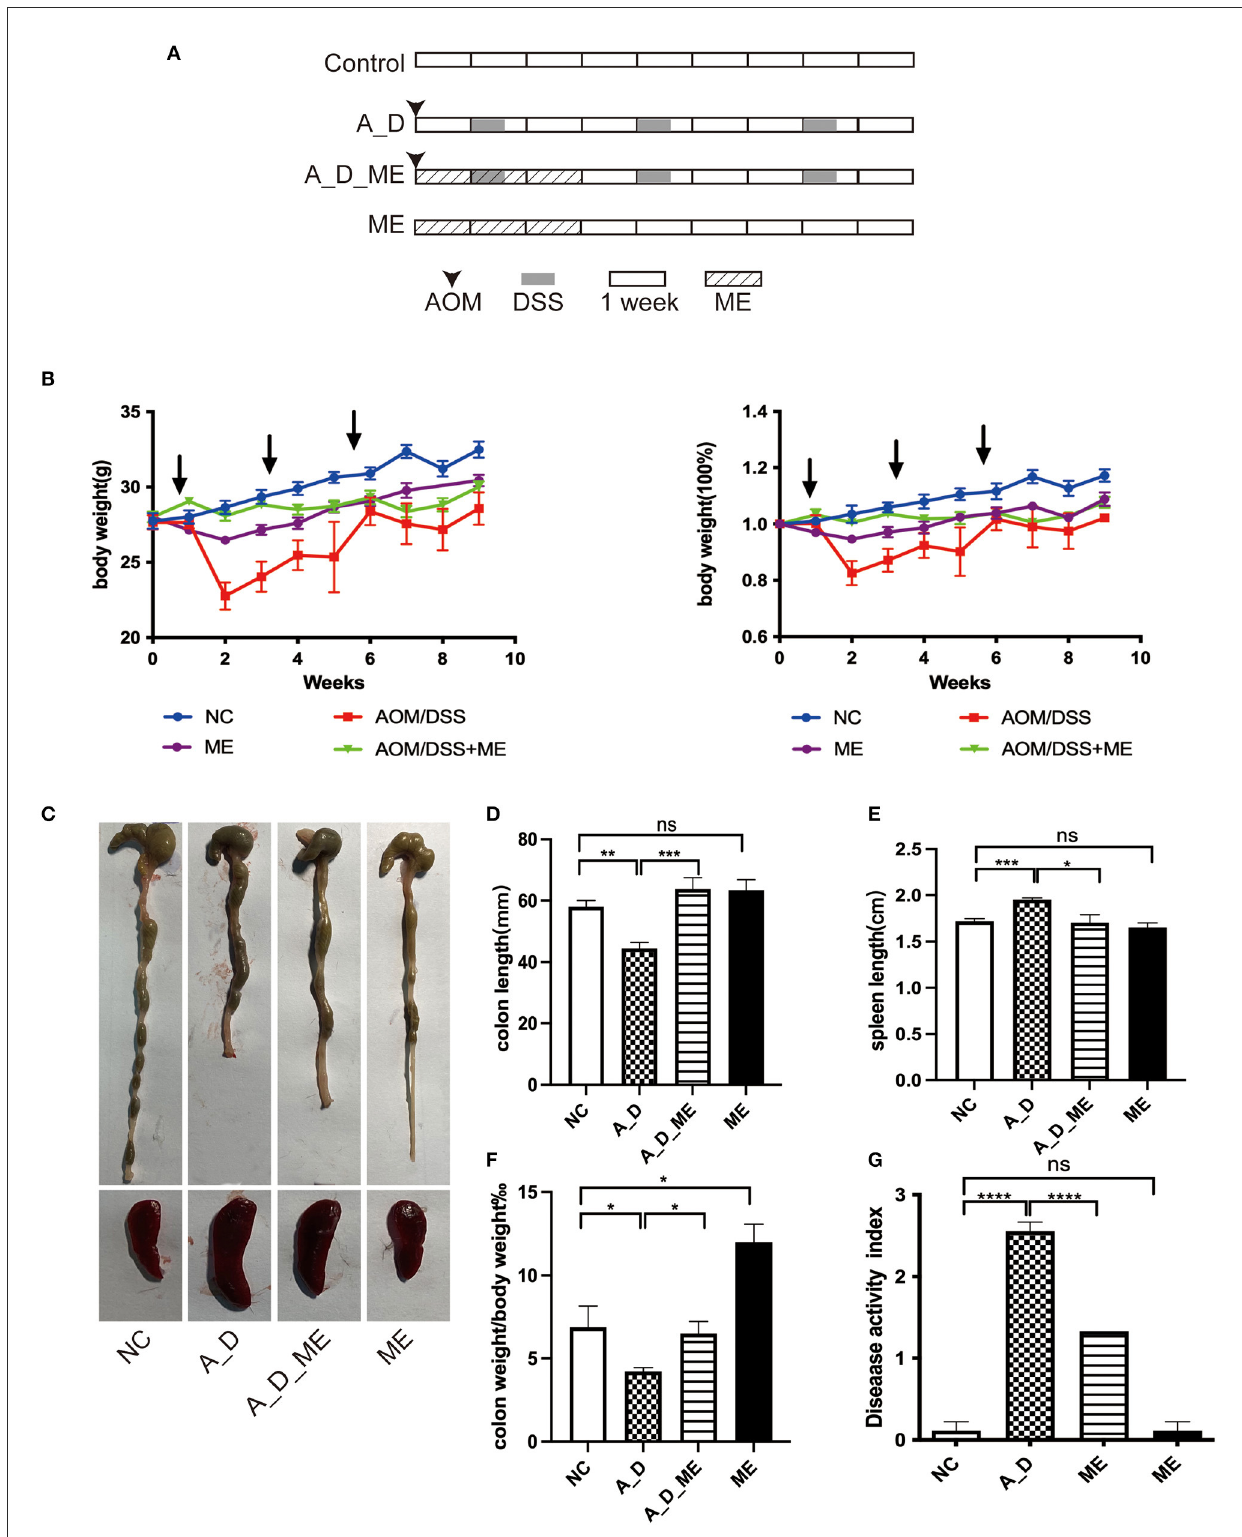
FIGURE1 Effects of ME administration on the development of AOM/DSS-induced tumorigenesis in C57BL/6 mice ( n = 6). (A) protocol, (B) body weight changes and the ratio of weight changes to the starting weight, (C) macroscopic morphologies of colon and spleen, (D) colon length, (E) spleen length, (F) the radio of colon weight to body weight, (G)